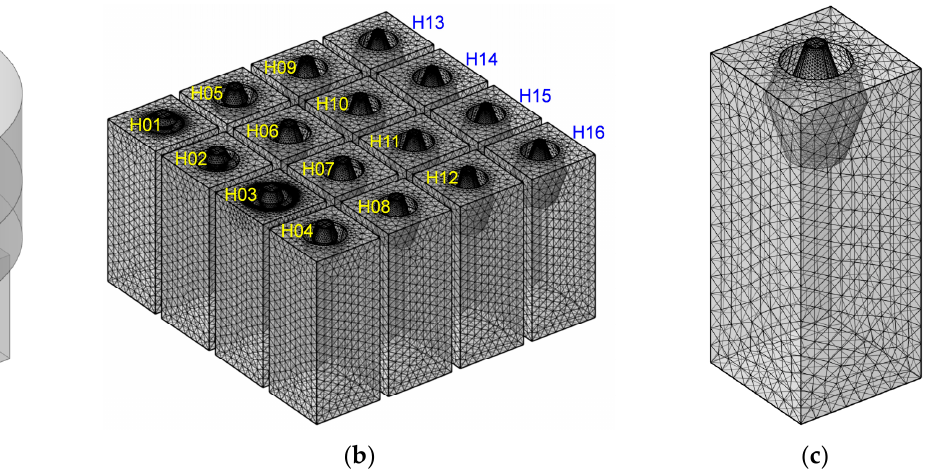
Figure 14. Three-dimensional finite element simulation model for the multiple parallel connection HRs with embedded aperture which consist of a tangent sectional shape of olive and a cross-sectional shape of round. ( a ) The acoustic finite element simulation model; ( b ) the meshed model for multiple parallel connection HRs; and ( c ) the single HR.